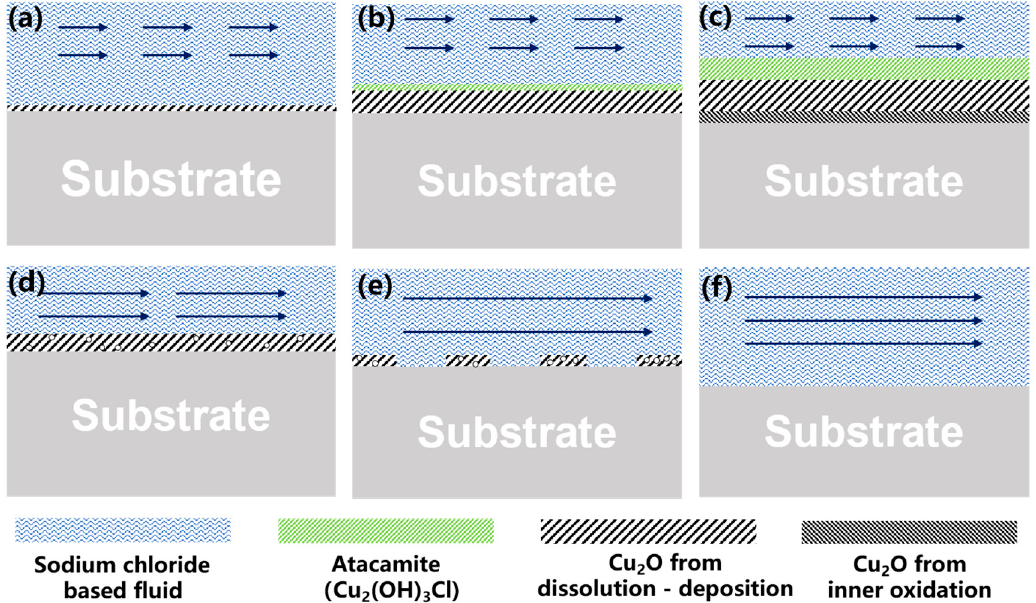
Figure 10. Effect of flow velocity on the corrosion product film of the 90/10 copper–nickel alloy in sodium chloride-based fluid: ( a – c ) the schematics of the corrosion product film formation process at low flow velocities of 0.5–1.5 m/s; ( d – f ) the schematics of the corrosion product films formed at 3 m/s, 4 m/s, and 4.7 m/s, respectively.